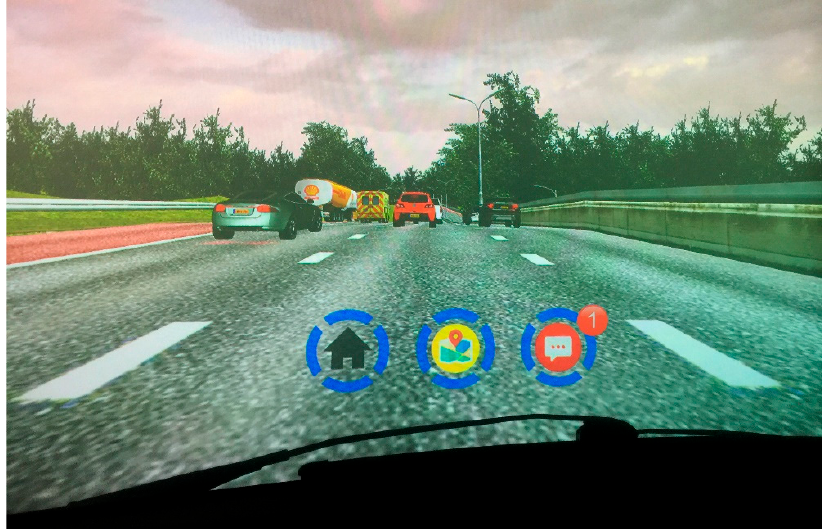
Figure 4. Screenshot of the simulation presenting the sub-symbol of the received Text Message as a superscript red circle with the number of received and stored messages.